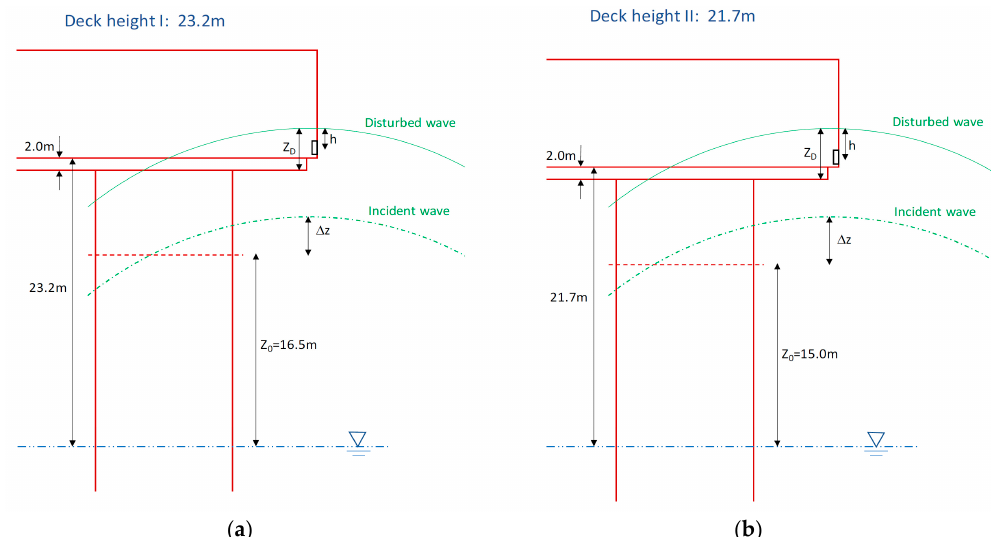
Figure 8. Schematic illustration of the height levels on platform, with upwave part of platform shown for two deck heights: ( a ) cellar deck height 23.2 m (i.e., water depth 150.1 m), and ( b ): cellar deck 21.7 m (i.e. water depth 151.6m). Symbols are defined in the text. Approximate geometrical scale only.